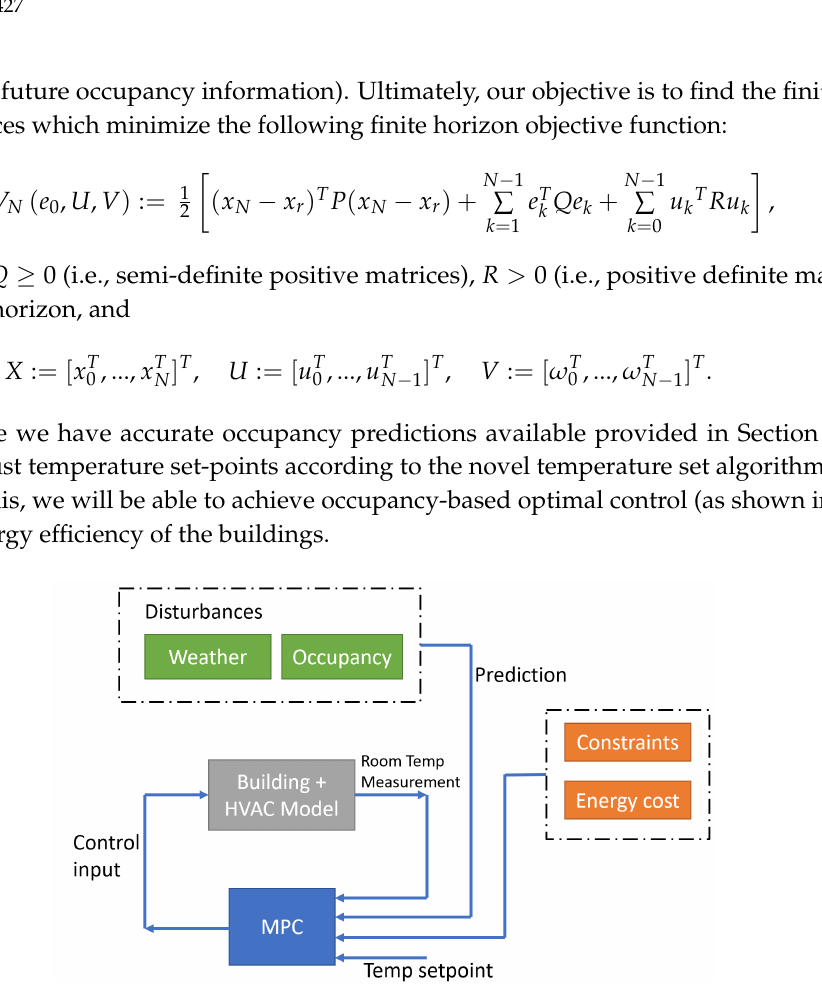
Figure 3. The proposed occupancy-based control setup for a building HVAC